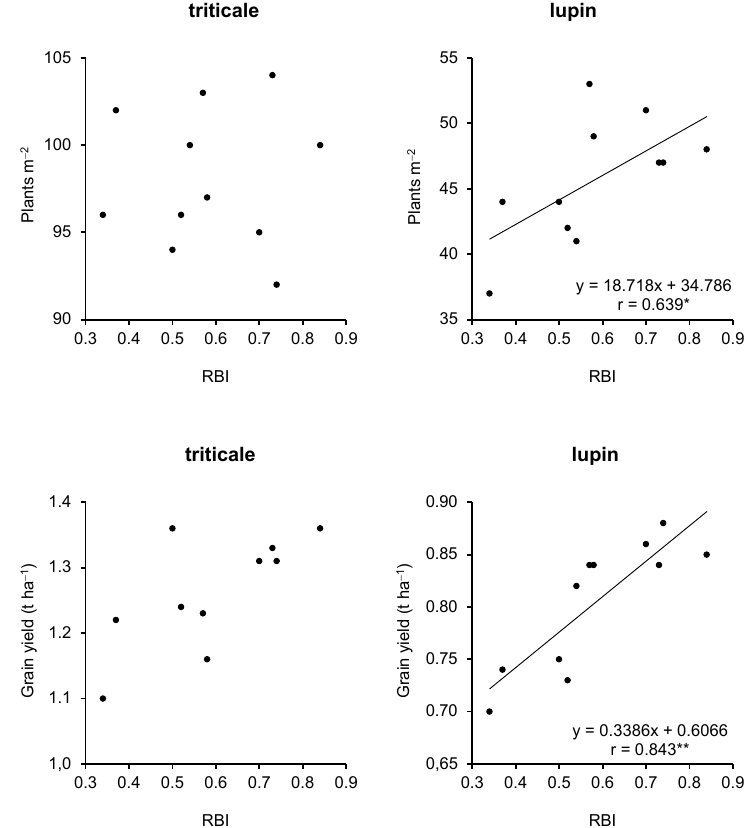
Fig. 3. The linear relationship between resistance to burial index (RBI) of triticale-lupin mixture and the plant density of mixture components at the harvest. Regression equation with line and Pearson correlation coefficient (r), is shown when r is significant (*,** – at 0.05 and 0.01 probability level respectively, n=11). The points represent treatment means of untransformed data averaged over 2015–2017.